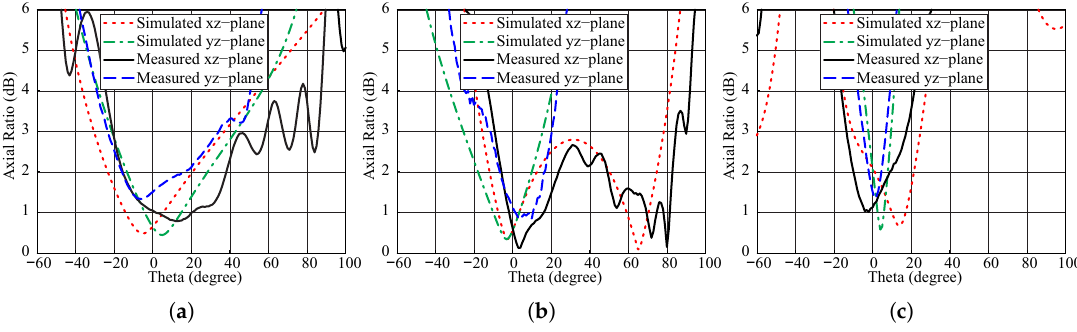
Figure 12. Simulated and measured axial ratios (ARs) versus angle theta of the proposed antenna: ( a ) 1.9 GHz; ( b ) 2.73 GHz; ( c ) 3.7